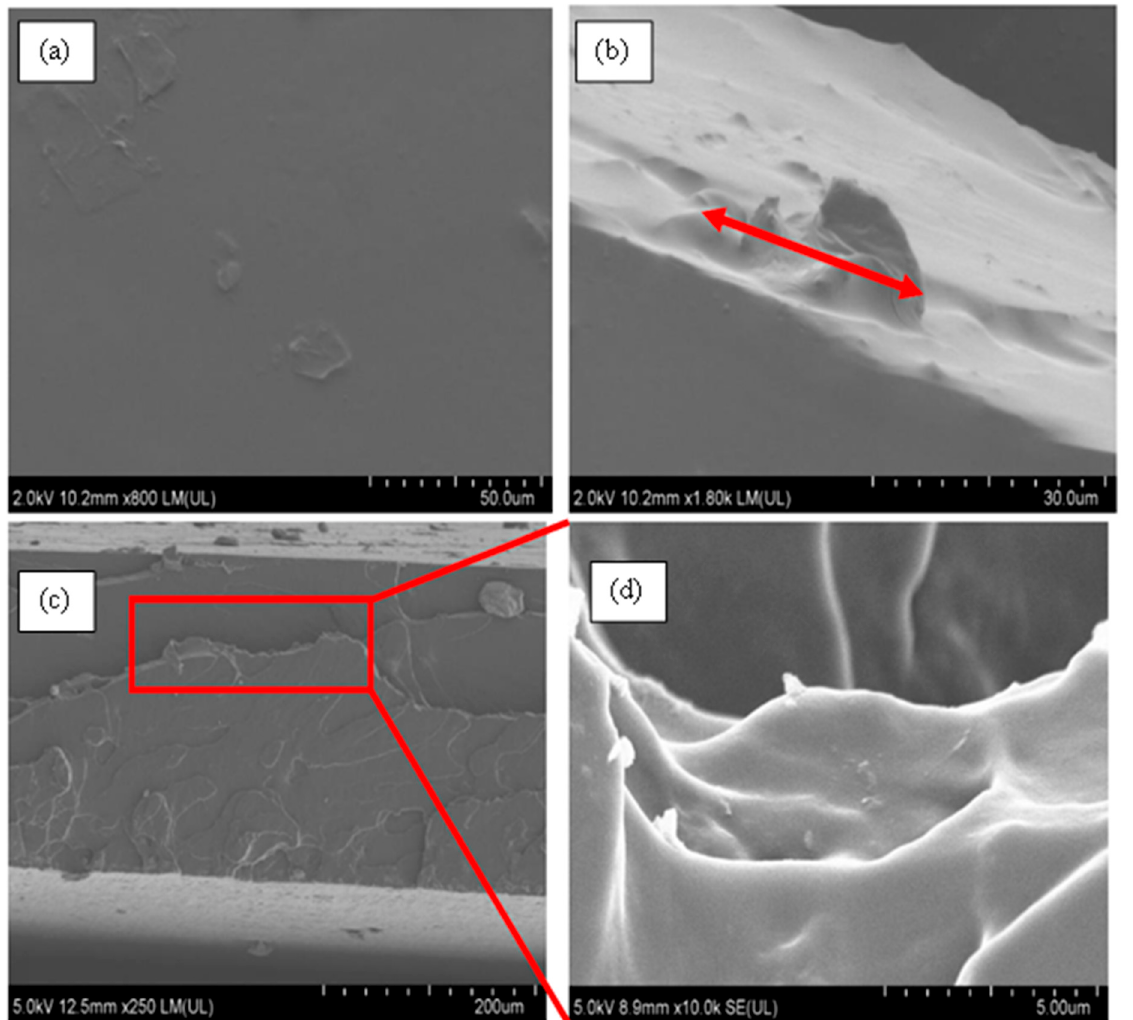
Figure 12. FE-SEM micrographs of PU-0.2%MWCNT. ( a ) Surface morphology at × 800, ( b ) cross-sectional morphology prior to fracture, ( c ) tensile fracture surface at × 250, and ( d ) fracture lines on fractured surface at ×10k.